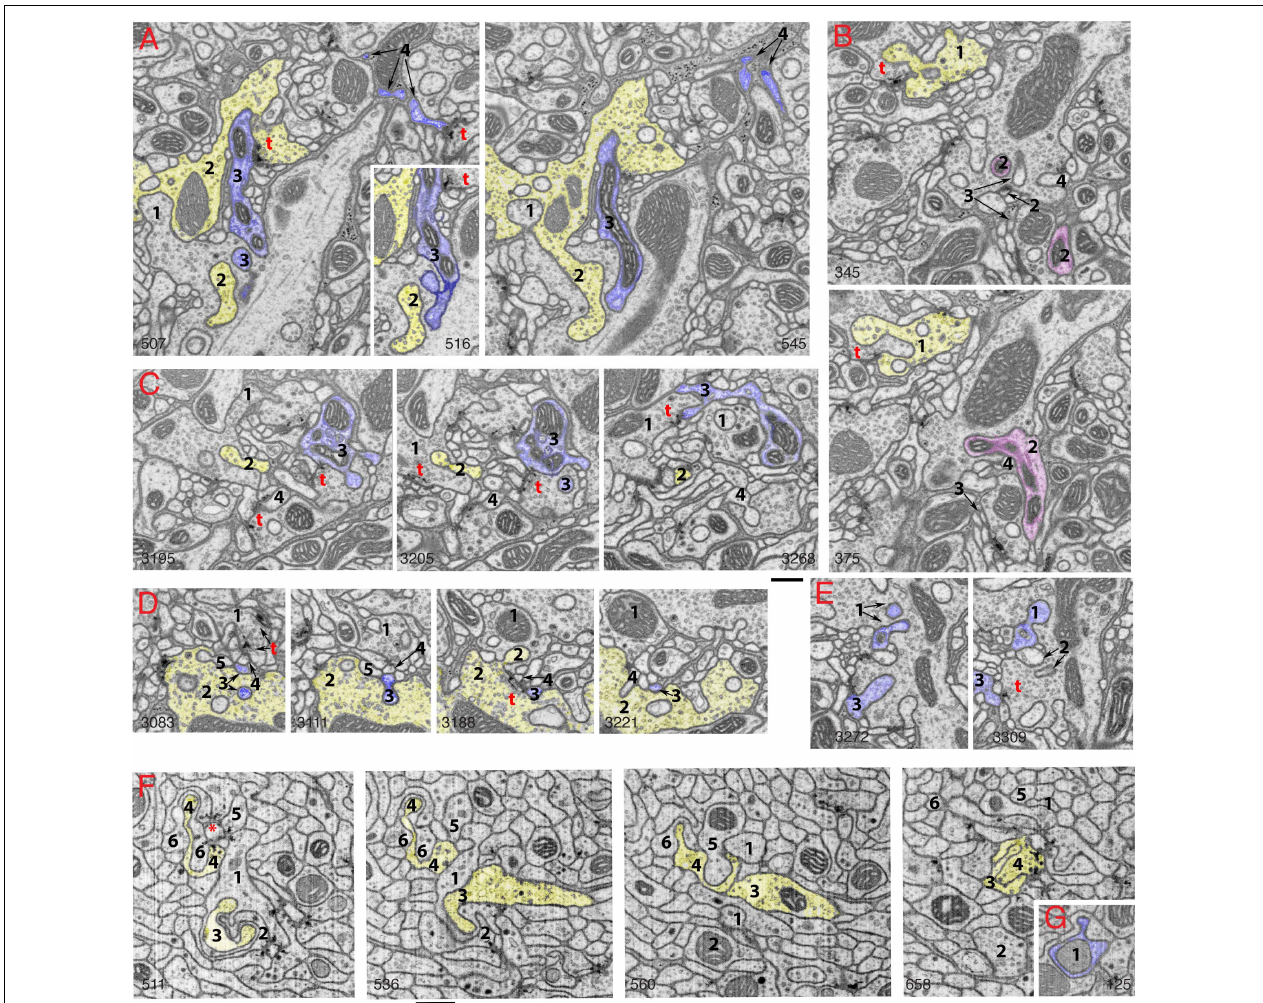
FIGURE 2 | Invaginating structures in the Drosophila brain. Examples are FIB-SEM image stacks of the protocerebral bridge (A–E) and mushroom body (F,G) . Blue , dendrite; yellow , axon; magenta , either dendrite or axon or both. Axon terminals were defined by accumulation of synaptic vesicles or were traced to a presynaptic T-bar; dendrites were traced to a postsynaptic process. Invaginating structures are defined as outward projections. (A) Neurites 1 and 2 are large axon terminals that co-invaginate (neurite 1 invaginates into neurite 2 while neurite 2 invaginates into neurite 1). Neurite 3 is a dendrite that invaginates into axon 1, and neurite 3 is one of the two postsynaptic processes of a T-bar synapse ( t ) of axon 2. Neurite 4 is a dendrite that invaginates into a glial cell process; neurite 4 also is one of two postsynaptic processes at a T-bar synapse in an adjacent axon terminal (left image). (B) Neurite 1 is an axon terminal that invaginates into an adjacent axon terminal; neurite 1 is also postsynaptic at a T-bar synapse in the adjacent terminal (bottom image). Neurites 2, 3, and 4 invaginate into the same large axon terminal; 3 and 4 are small dendrites. Neurite 2 ( magenta ) was traced for a long distance ( > 4 µ m). This neurite 2 displays features of both presynaptic and postsynaptic structures and forms at least two or three T-bar synapses as well as two or three postsynaptic processes with different synapses (not shown). (C) Axon terminal 1 is invaginated by axon terminal 2 and also invaginates another terminal. Neurite 3 is a dendrite that forms four spine-like structures, including one that forms a postsynaptic process at a synapse with terminal 1 and another that invaginates into a subjacent terminal. Neurite 4 is a dendrite that also invaginates into the same subjacent terminal. (D) A structure from axon terminal 2 invaginates into axon terminal 1, while structures from dendrites 3, 4 and 5 invaginate into terminal 2. (E) Neurites 1, 2, and 3 are projections from dendrites that invaginate into the same large axon terminal; neurite 1 has two invaginating structures. Neurite 3 also bears some T-bar like structures (not shown). Invaginating structures from axon terminals can be filled with synaptic vesicles as seen in panels (A,B) , or devoid of vesicles as evident in panel (D) . (F) Neurites 1-6 are all small axon terminals with relatively few synaptic vesicles. These axons invaginate with each other and also often cluster to form synapses on central dendrite processes. (G) An example of a dendrite (1) invaginating into an axon terminal. The number in the lower left or lower right corner of each micrograph indicates its z position in the FIB-SEM image stack. t = T-bar (only selected ones are labeled). Scale bars are 500 nm for panels (A–E) and (F–G) . Note that the protocerebral bridge neuropil (A–E) contains abundant invaginating processes from large axon terminals and dendrites, while the mushroom body neuropil (F,G) contains abundant invaginating processes from small axon terminals but few from